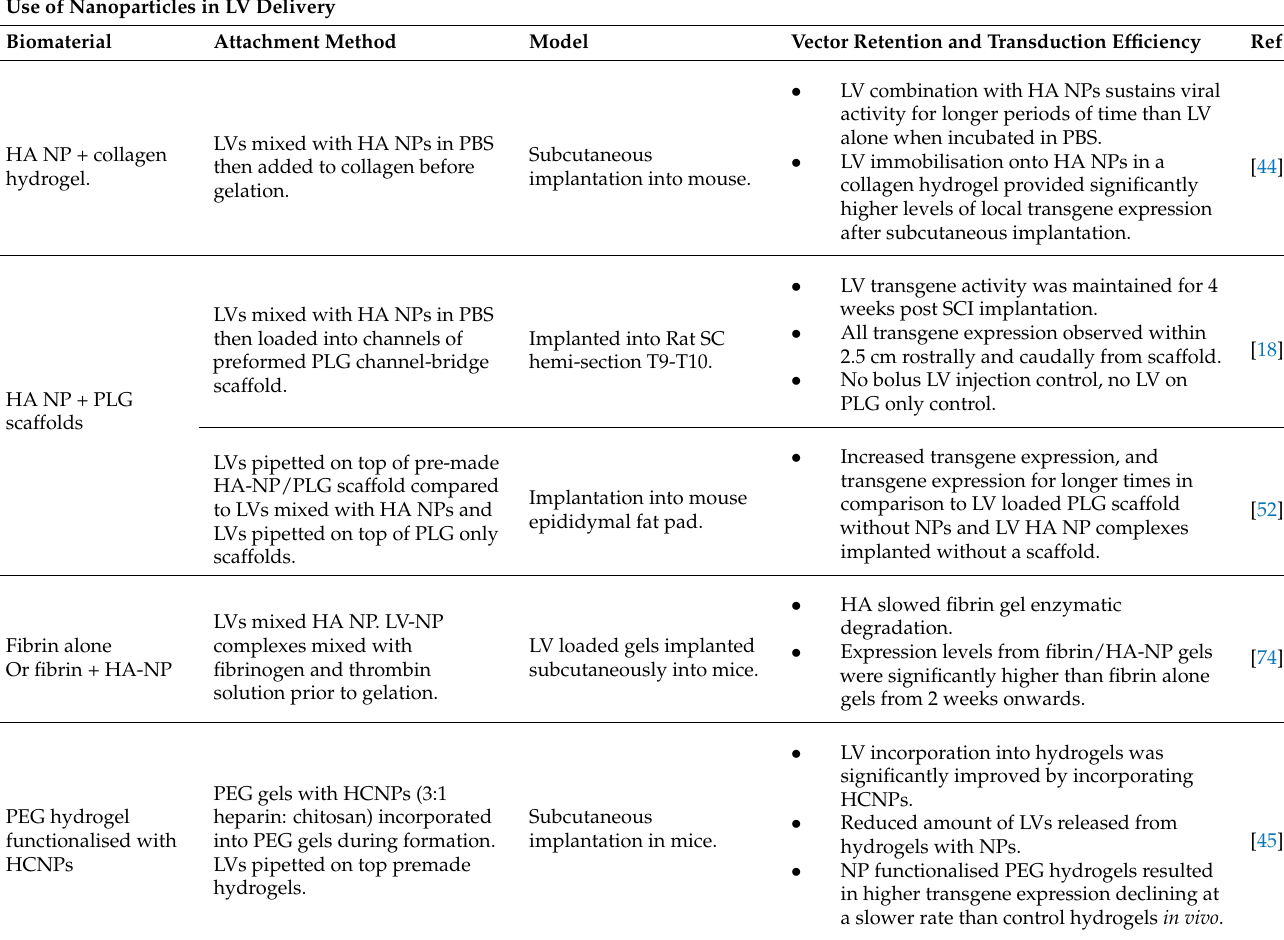
Table 5. Studies delivering LV in combination with Nanoparticles. NPs; Nanoparticles, HA; Hydroxyapatite, PLG; poly (lactide-co-glycolide) HCNPs; heparin-chitosan nanoparticles. Use of Nanoparticles in LV Delivery Biomaterial Attachment Method Model Vector Retention and Transduction Efficiency